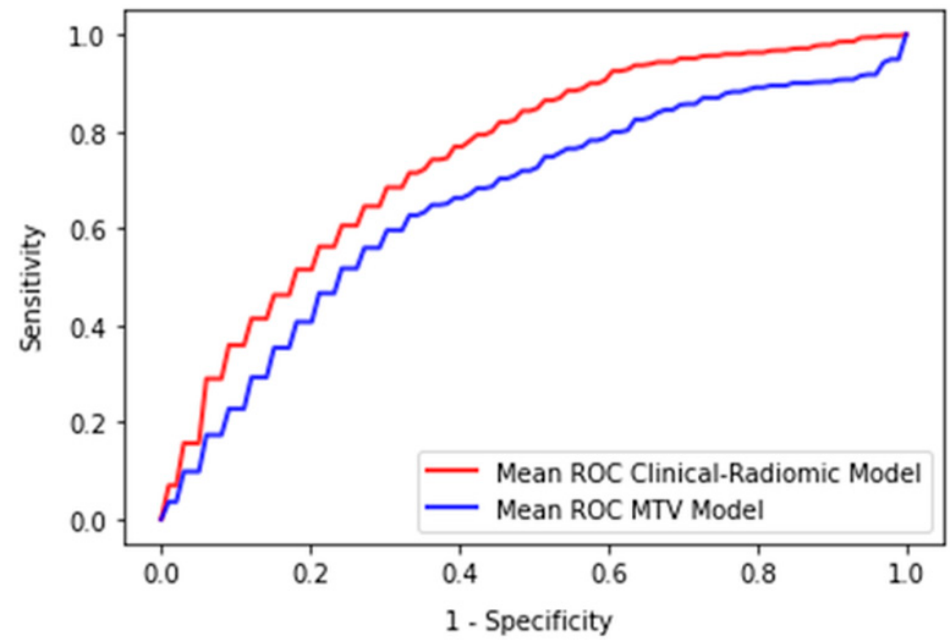
Figure 3. Mean ROC Curve of the MTV-based logistic regression model and the radiomic-based logistic regression model.